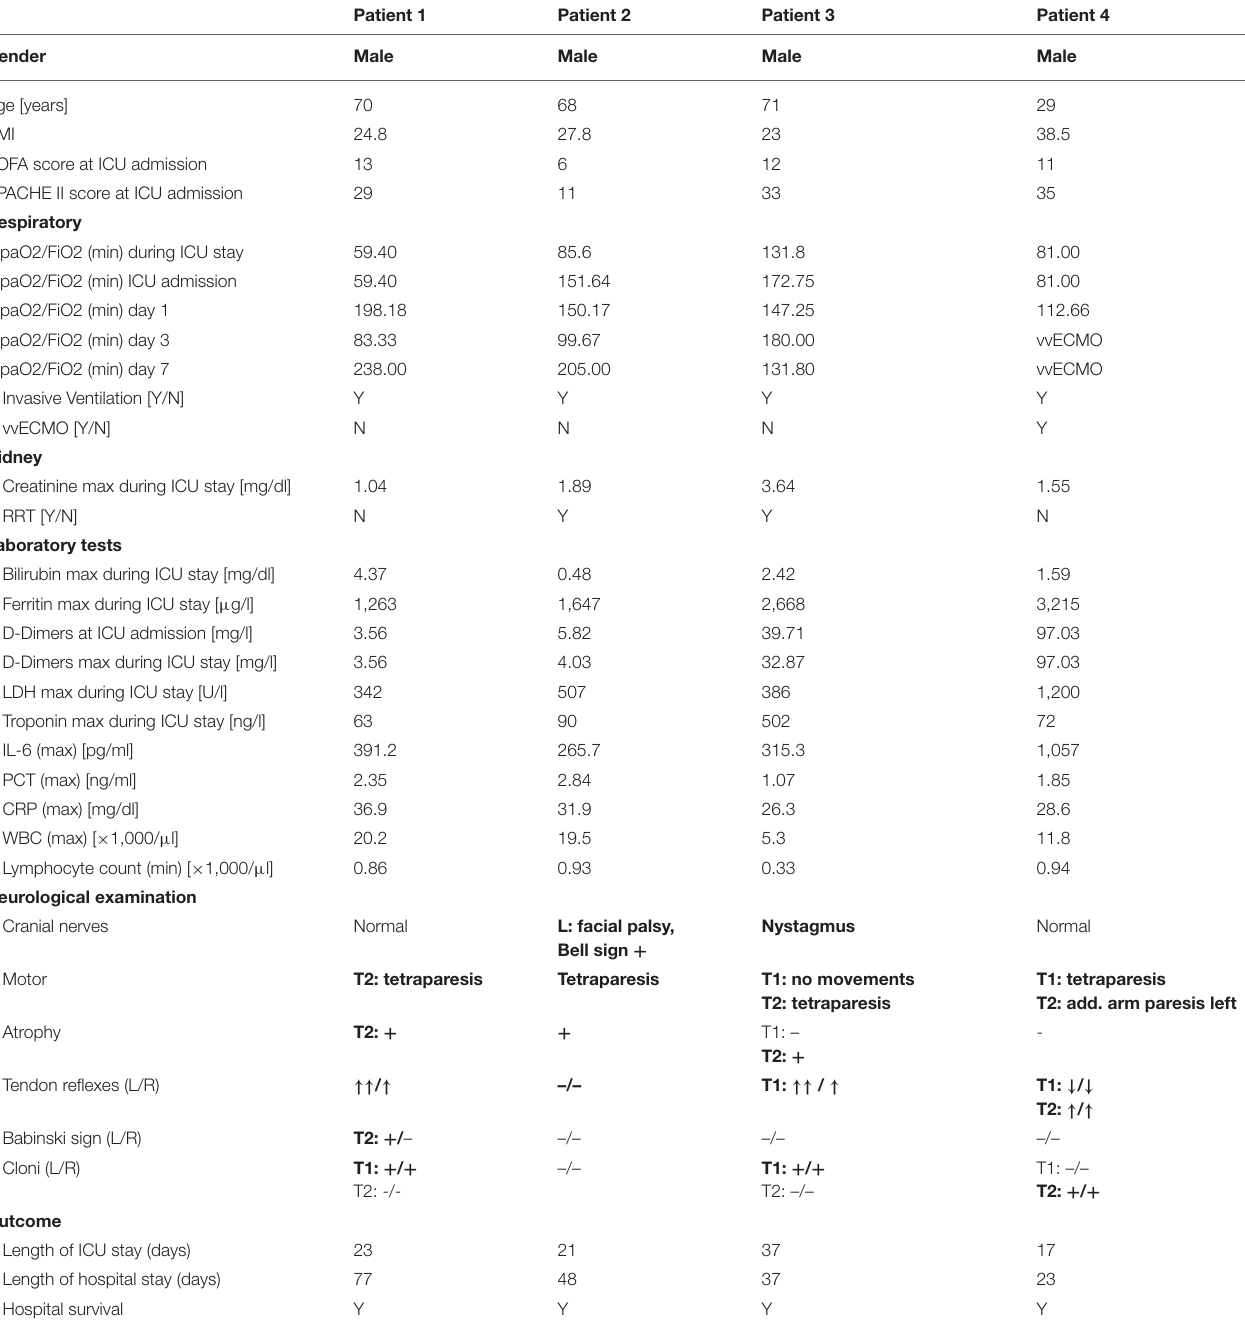
TABLE 1 | Basic clinical, laboratory, and neurological characteristics of all four patients. Patient 1 Patient 2 Patient 3 Patient